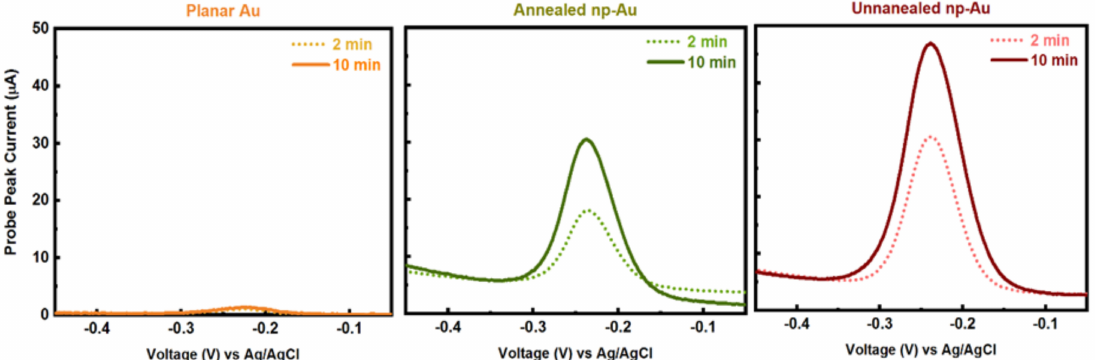
Figure A4. Example SWV raw data for two extreme electro-grafting times (2 and 10 min) used to generate Figure 3—Effect of electrode morphology (unannealed, annealed np-Au and pl-Au) and electro-grafting duration (1, 2, 5, 8, 10 min) on the peak current (surrogate for immobilized probe amount deducted from SWV measurements).